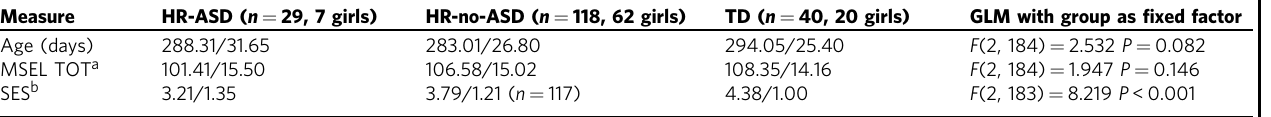
Table 1 Participant characteristics by group at the 10-month assessment, fi nal samples (Mean/SD)